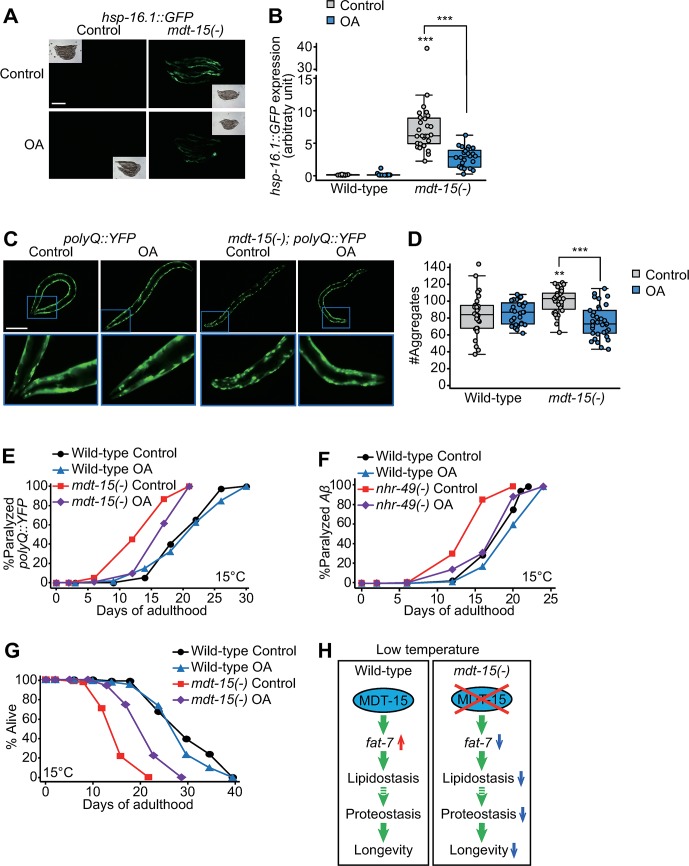
Supplementation of OAs ameliorates proteotoxicity and short life span caused by reduced UFA/SFA ratio at low temperatures.(A) Images of hsp-16.1p::hsp-16.1::GFP [hsp-16.1::GFP] transgenic worms in wild-type and mdt-15(tm2182) [mdt-15(-)] backgrounds at 15 °C on control or OA-containing plates. Scale bar: 200 μm. (B) Quantification of hsp-16.1::GFP treated with OA at 15 °C. Images of the individual worms were obtained separately for the quantification (n ≥ 22 from three independent experiments, two-tailed Student t tests, ***p < 0.001). See S7 Table for the standard deviations of box plot data in this figure. (C) Images of polyQ::YFP (Q35::YFP) transgenic worms treated with OA in wild-type and mdt-15(-) backgrounds at 15 °C. Scale bar: 200 μm. (D) Quantification of the data in panel C (n ≥ 28 from three independent experiments, two-tailed Student t tests, **p < 0.01, ***p < 0.001). The data shown in Fig 6B are used in this panel for comparison. (E) Age-dependent increases in the paralysis of polyQ::YFP transgenic animals in mdt-15(-) and wild-type backgrounds at 15 °C. The transgenic worms were fed with OA for their whole life. The paralysis assays were performed 6 times by two independent researchers. Four repeats were performed with synchronized worms from L1 stage, and the other two repeats were performed with worms treated with OA from eggs. For five out of the six repeats, OA substantially suppressed the accelerated age-dependent paralysis in mdt-15(-) animals that expressed polyQ::YFP (S5 Table) (log-rank test, p = 0.3895 for wild-type control diet versus wild-type OA, p < 0.0001 for mdt-15(-) control diet versus mdt-15(-) OA). (F) Age-dependent increases in the paralysis of Aβ transgenic animals in wild-type and nhr-49(gk405) [nhr-49(-)] backgrounds under control or OA-treated conditions (log-rank test, p = 0.091 for wild-type control diet versus wild-type OA, p < 0.0001 for nhr-49(-) control diet versus nhr-49(-) OA). See S5 Table for statistical analysis and additional repeats of the paralysis assays. (G) Life-span curves of wild-type and mdt-15(-) animals under control or OA-treated conditions at 15 °C. We also showed that OA feeding partially suppressed the defects in the growth of mdt-15(-) animals (S6C Fig). See S4 Table for statistical analysis and additional repeats of the life-span assays and S6 Table for the Cox proportional hazard regression analysis. (H) A schematic model summarizing the current study. At low temperatures, wild-type MDT-15 up-regulates fat-7, which is crucial for maintaining lipidostasis and subsequently proteostasis, which lead to longevity. In mdt-15(-) mutants, the expression of fat-7 is low, and this in turn causes impaired lipidostasis and proteostasis leading to a very short life span at low temperature. GFP, green fluorescent protein; hsp, heat shock protein; MDT-15, Mediator 15; nhr, nuclear hormone receptor; OA, oleic acid; polyQ, polyglutamine; SFA, saturated fatty acid; UFA, unsaturated fatty acid; YFP, yellow fluorescent protein.